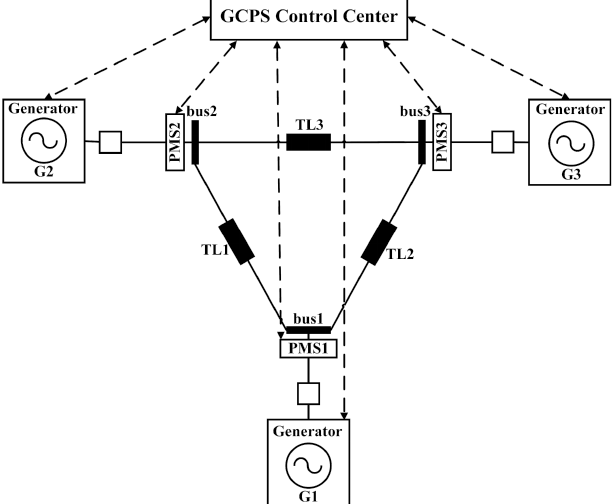
Figure 2. A modified, redrawn and relabeled IEEE 9-bus system with grid elements that are PMSs.